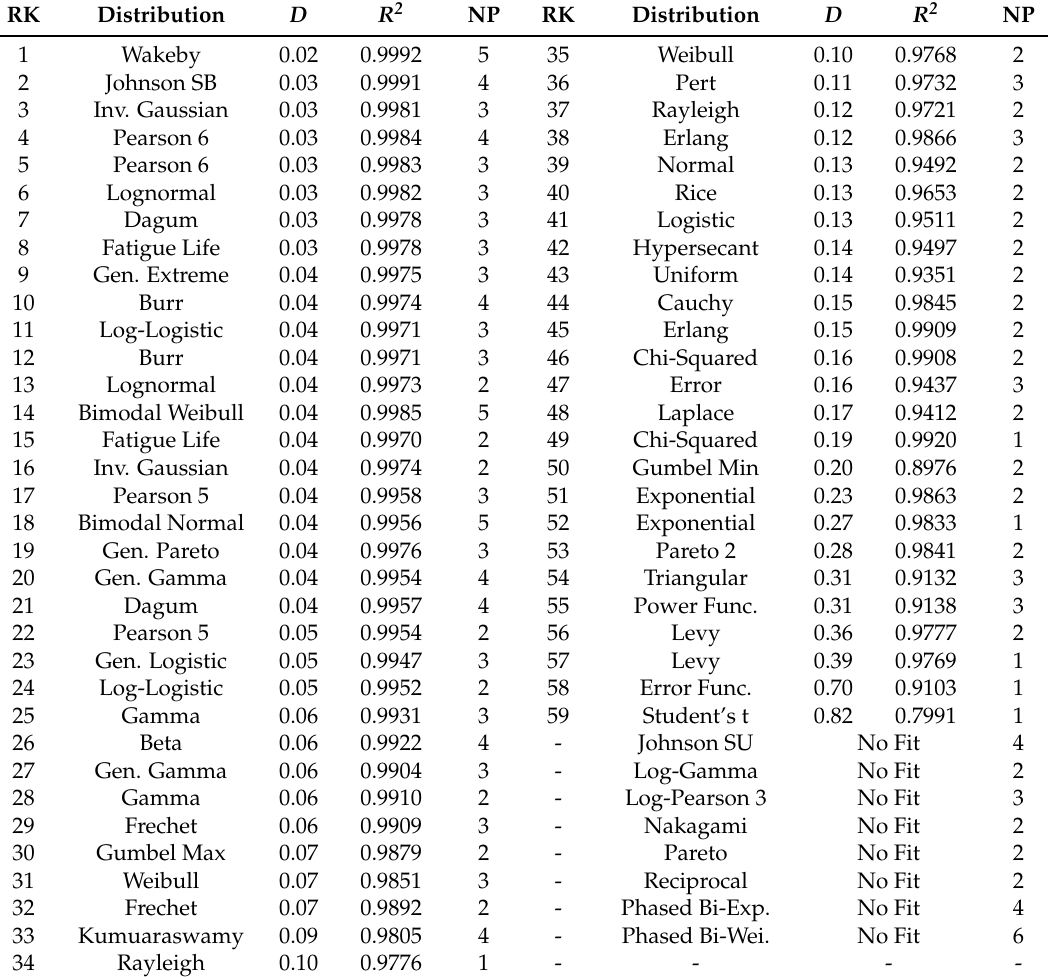
Table 2. Distributions ranked (RK) by Kolmogorov-Smirnov statistic ( D )-values with their number of parameters (NP). D - and coefficient of determination ( R 2 )-values are averages over all meteorological